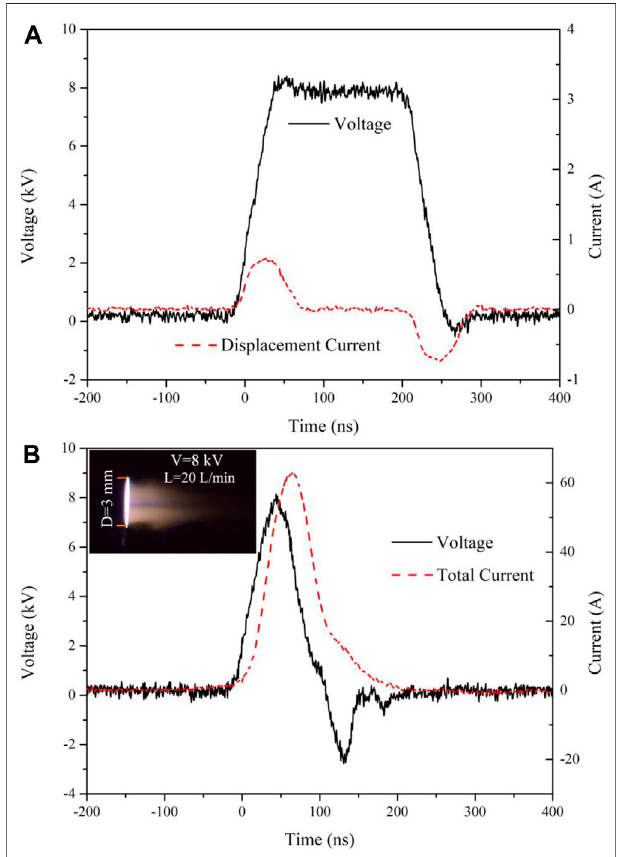
FIGURE 3 | Voltage and current waveforms on the pin electrode. (A) Displacementcurrentand (B) totalcurrentoftheairplasmajet.Theair fl owrate is 20 L/min. The amplitude of the voltage is 8 kV. The pulse width of the voltage is 250 ns. The frequency ofvoltage is 5 kHz. The diameter of the nozzle is 3 mm.